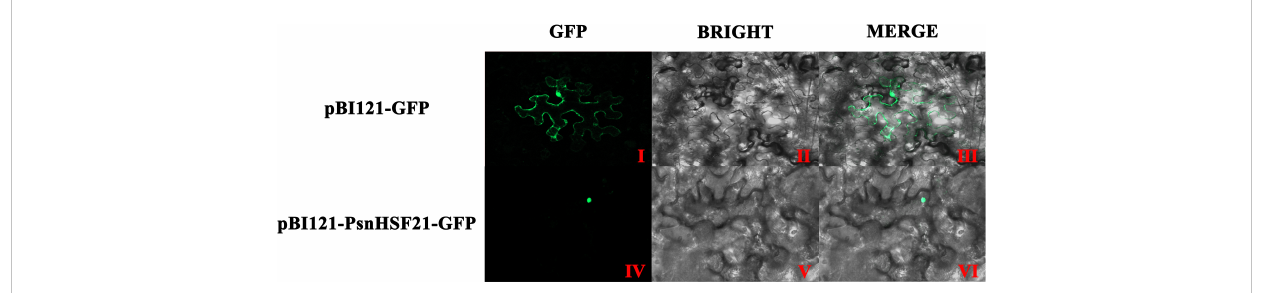
FIGURE 8 Subcellular localization of PsnHSF21 protein. The pBI121-GFP-PsnHSF21 fusion vector and pBI121-GFP control vector were transferred into tobacco leaf cells by instantaneous transformation. After 24 – 36 h of transformation, the pictures were imaged by the laser confocal microscope. ( I, IV ) are GFP fl uorescence detection, ( II, V ) are bright fi elds, and ( III, VI ) are superposition fi